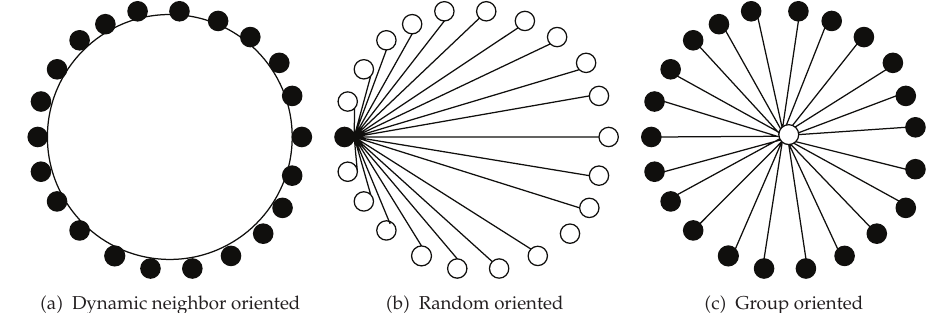
Figure 2: Communication